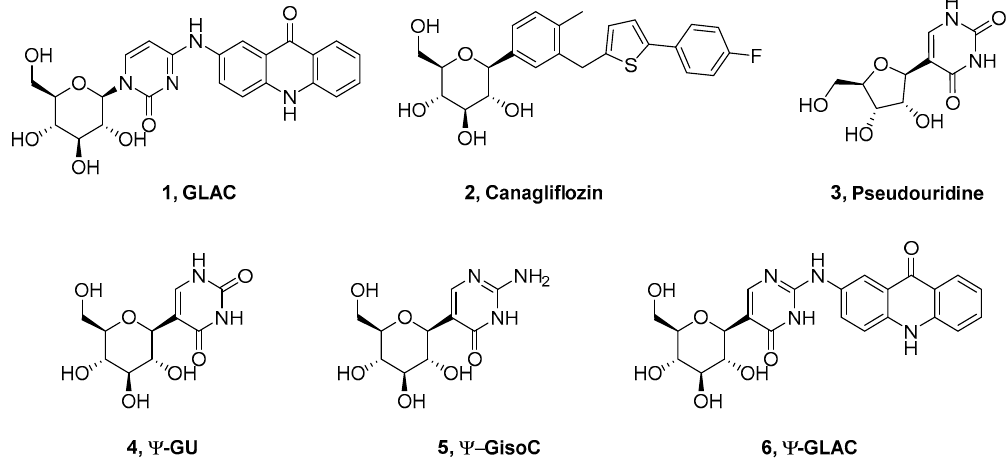
Figure 1. Known and target N - and C -glycosyl compounds.